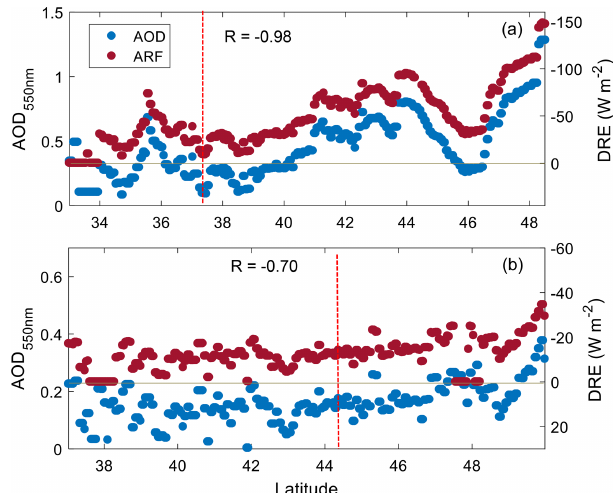
Figure 8. AOD 550 from MODIS (blue dots) and DRE BOA from GAME (red dots) along the CALIPSO track for GR (a) and BU (b) . The dashed red vertical lines represent the location of the EAR- LINET stations. The correlation coefficient between the DRE BOA and the AOD 550 , R , is reported in each